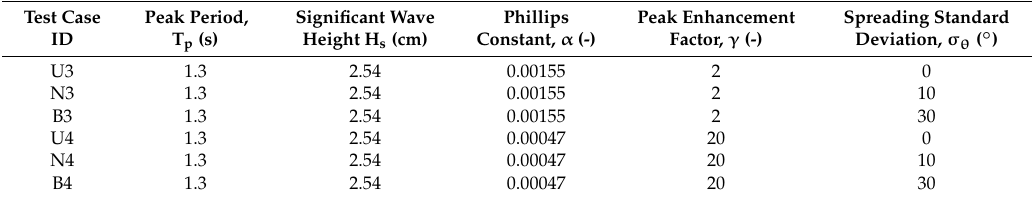
Table 1. Numerical input wave conditions for non-breaking waves based on the Vincent and Briggs experimental wave conditions.